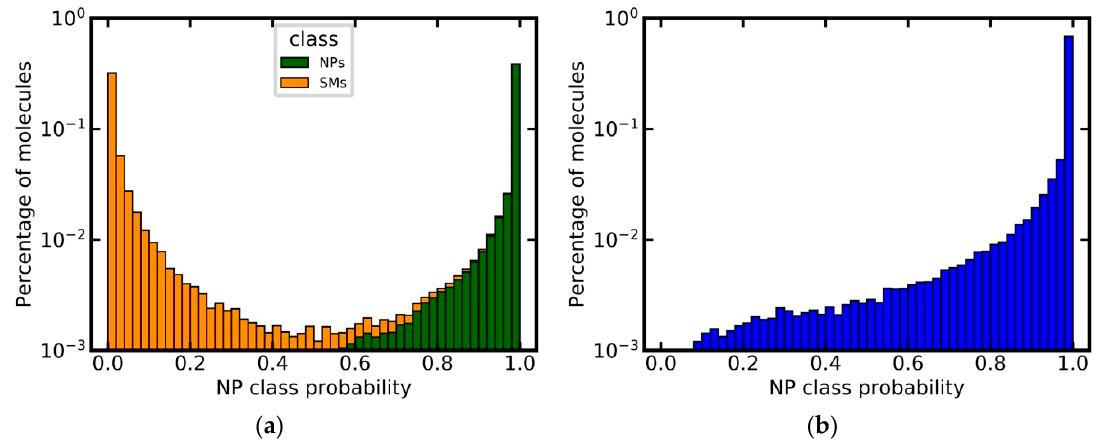
Figure 3. Predicted NP class probabilities distributions for ( a ) the independent test set (stacked